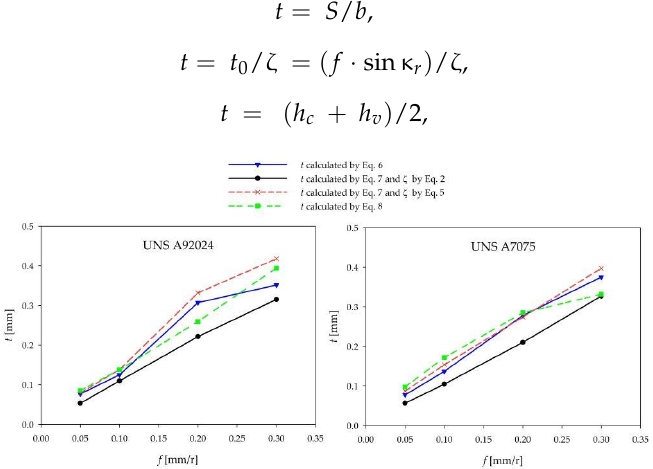
Figure 13. Chip thickness ( t ) as a function of feed (calculated by several methods).